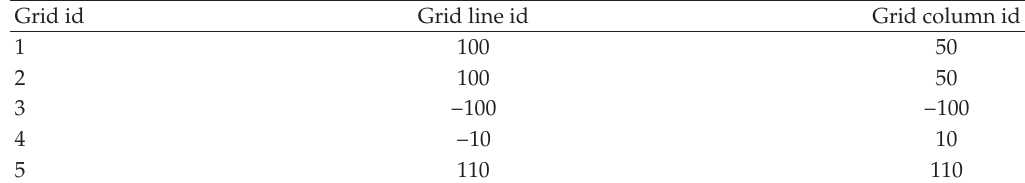
Table 4: Key control point properties.